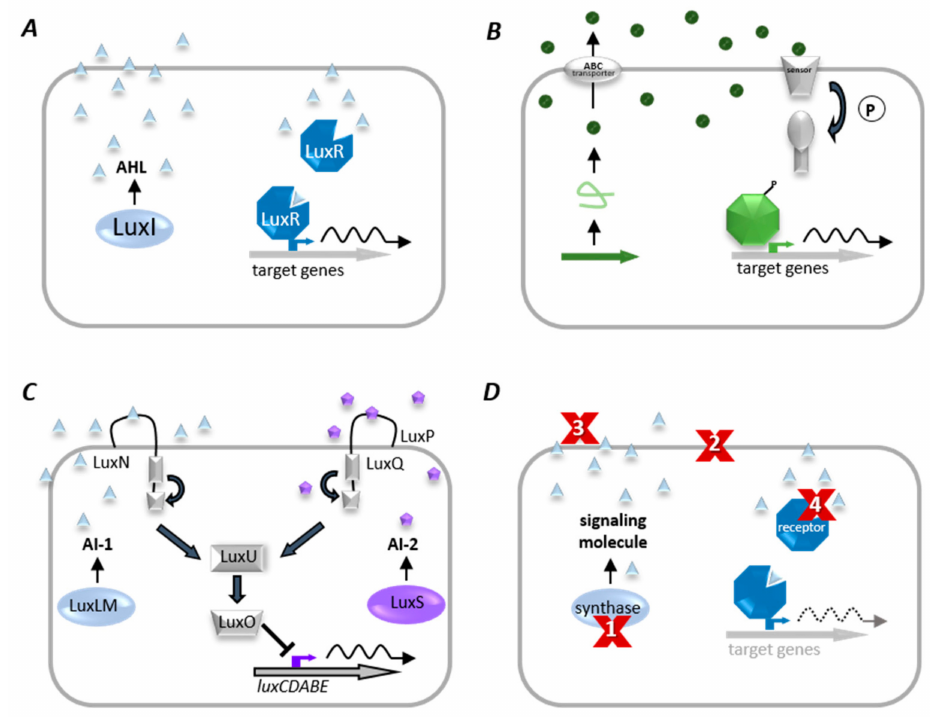
Figure 6. Quorum sensing (QS) systems and Quorum quenching (QQ) strategies. ( A ) Gram-negative bacteria produce diffusible autoinducers (AI, triangles) by a LuxI homologous synthase. AIs diffuse into the cell and bind to cognate receptor (LuxR homolog). This complex binds at target gene promoters and activates their transcription. ( B ) A precursor peptide (loop) is produced and modified (circles) by Gram-positive bacteria and then secreted via an ATP-binding cassette (ABC). A two-component system detects signaling molecules, and phosphorylated response protein binds to specific promoter genes to modulate their expression. ( C ) The QS system of V. harveyi combines Gram-negative and Gram-positive QS elements, in which acyl-homoserine lactones (AI-1, triangles) are synthesized by LuxLM, and a second universal AI (AI-2, pentagons) is synthesized by the enzyme LuxS. AIs are detected by two-component systems whose signals are transduced by phosphorelay and end in the expression of the luciferase structural operon ( luxCDABE ). ( D ) Examples of QQ strategies. (1) inhibition of AI biosynthesis; (2) inhibition of signal transport; (3) degradation, modification, or antagonism of AIs, and (4) inhibition of signal